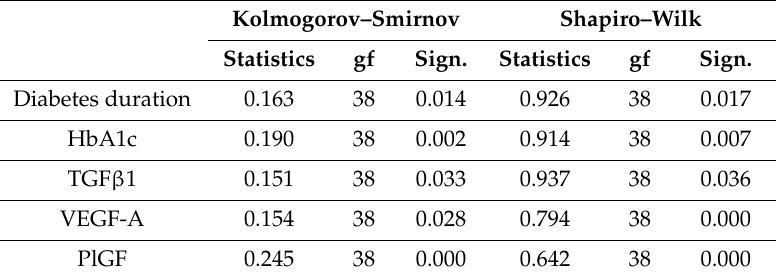
Table 2. Normality test.